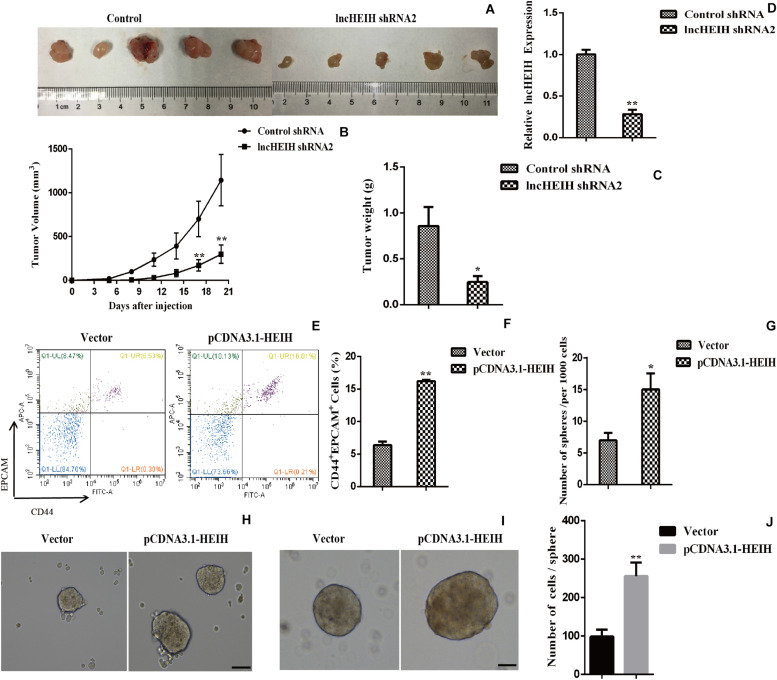
LncHEIH promotes in vivo tumorigenesis of gastric cancer cells and expansion of gastric CSC. (A) HGC-27 cells transfected with Ctrl shRNA or lncHEIH shRNA were injected into nude mice (n = 5), which were killed by carbon dioxide euthanasia 20 days after injection. (B) Tumor volumes were calculated every 3 days starting at 5 days after injection. Bars indicate SD. (C) Tumor weights are represented as the mean tumor weights ± SD. (D) The expression level of lncHEIH in the harvested tumors was tested by qRT-PCR. (E,F) The percentage of CD44+EPCAM+ CSC among primary gastric cancer cells transfected with lncHEIH. (G,H) Representative images of oncospheres formed by primary gastric cancer cells cultured in serum-free spheroid suspension culture for 10 days and the number of spheres per 1000 cells (scale bar = 100 μm). (I,J) Representative image of oncospheres and the number of cells per sphere after 10 days (scale bar = 50 μm). Error bars denote ± SD. *P < 0.05, **P < 0.01, ***P < 0.001.